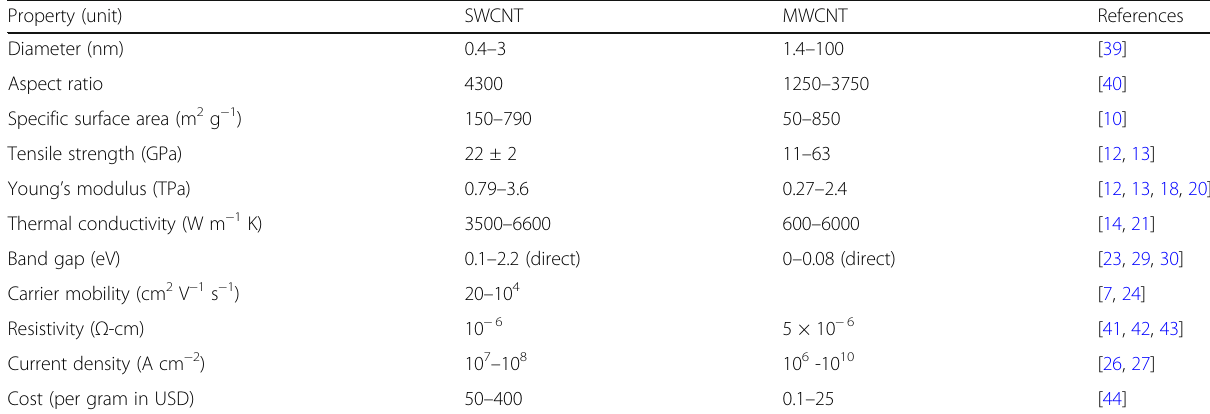
Table 1 Tabular representation of CNT properties Property (unit)